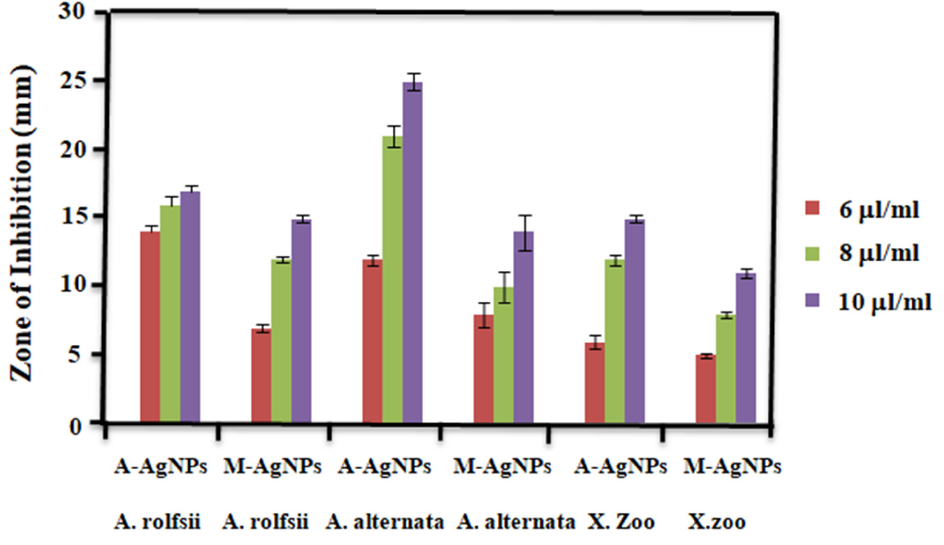
Figure 14. Antimicrobial activity of the AgNPs synthesized using aqueous leaf extract from A. indica and M. indica tested against A. rolfsii, A. alternata and X. Oryzae microbes. The value represents the mean of three replicates (±SD). Analysis of variance showed a significant difference in means ( p < 0.05).